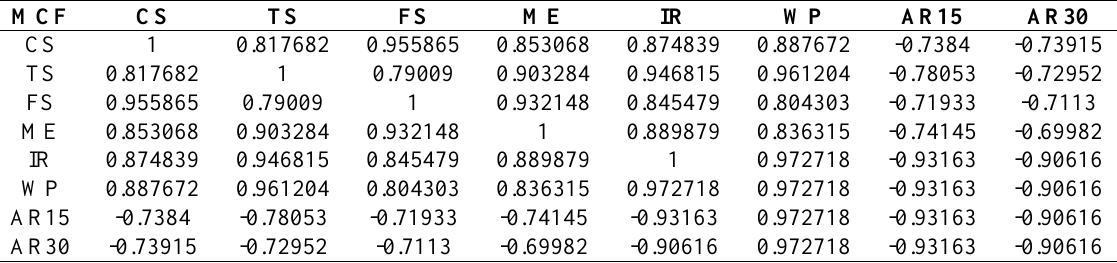
Table 11. Correlations among results of determined